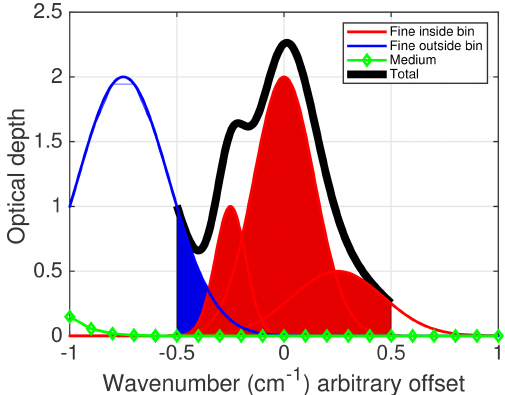
Figure 1. Line-by-line calculations from UMBC-LBL. The bin of interest is at ( − 0 . 5, + 0 . 5)cm − 1 . Line shapes whose line centers are within this bin (red) and within ± 1cm − 1 of the bin edge (blue) are computed using high spectral resolution; line centers that are further out (green) have the line shapes computed at medium reso- lution and then interpolated to a higher resolution; line centers even further away (not shown) are computed at coarse resolution. The black curve is the sum over all the line contributions within that